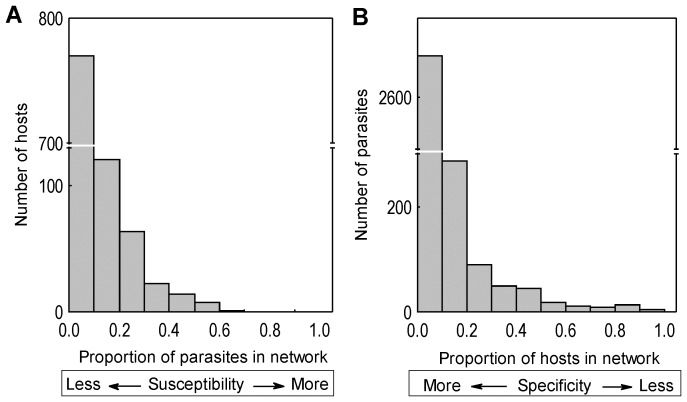
Interspecific interactions in 30 fish-parasite networks.When we assessed (a) the susceptibility of the hosts in relation to the proportion of parasite species in networks and (b) the specificity of the parasites in relation to the proportion of host species in networks, we observed that most parasites interact with a few fish species and that the hosts typically have a poor parasitic fauna.